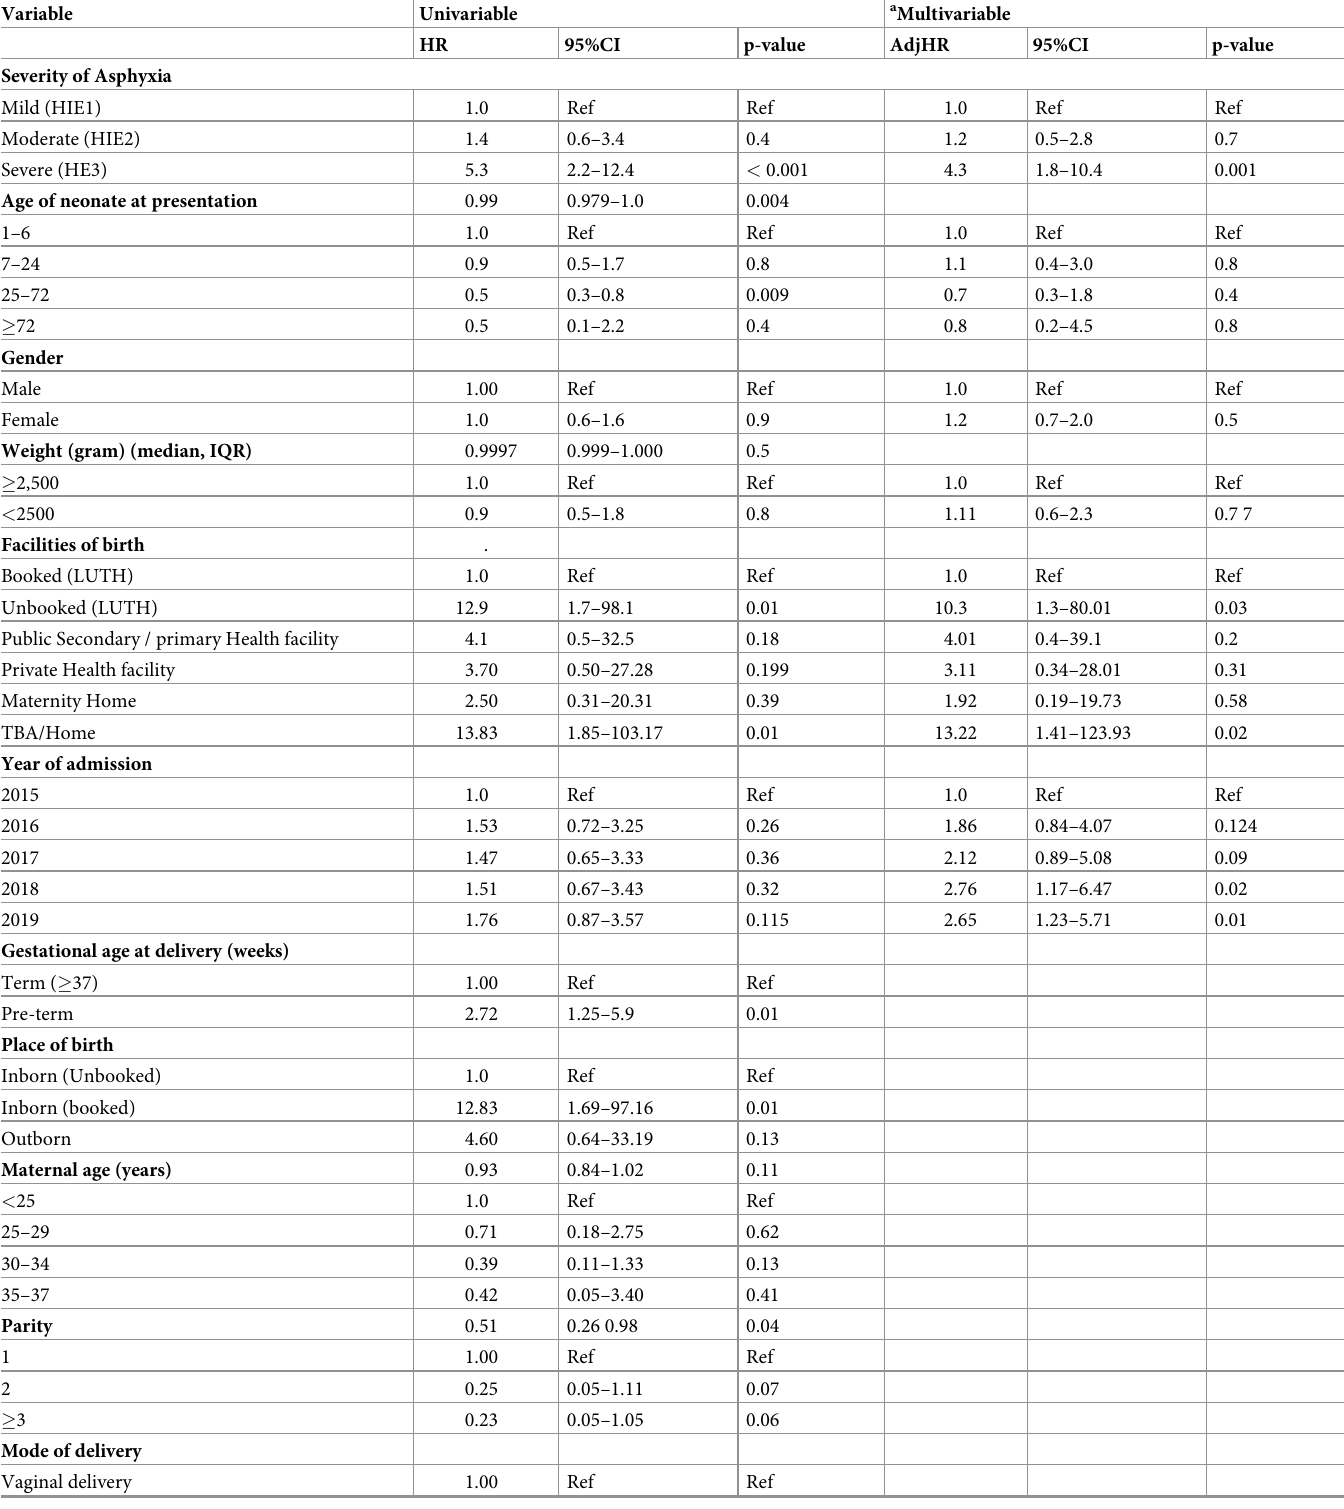
Table 6. Univariate and multivariable regression analysis of predictors of outcome among the HIE